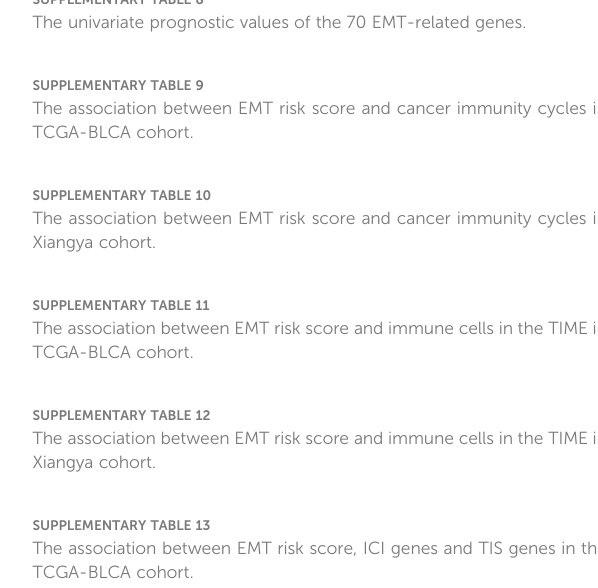
SUPPLEMENTARY TABLE 12 The association between EMT risk score and immune cells in the TIME in Xiangya cohort.